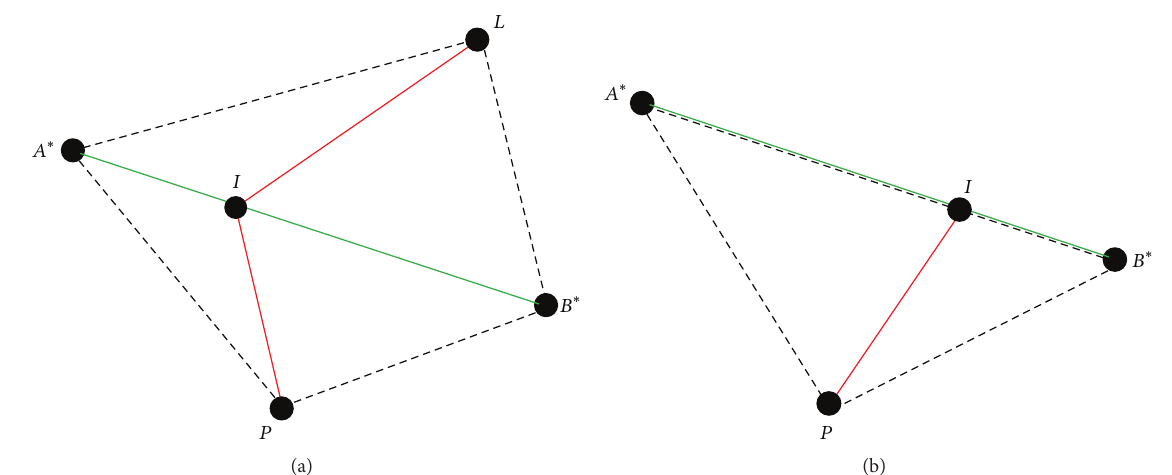
Figure 6: Examples of diamond cells. (a) A normal diamond cell. (b) A degenerate diamond